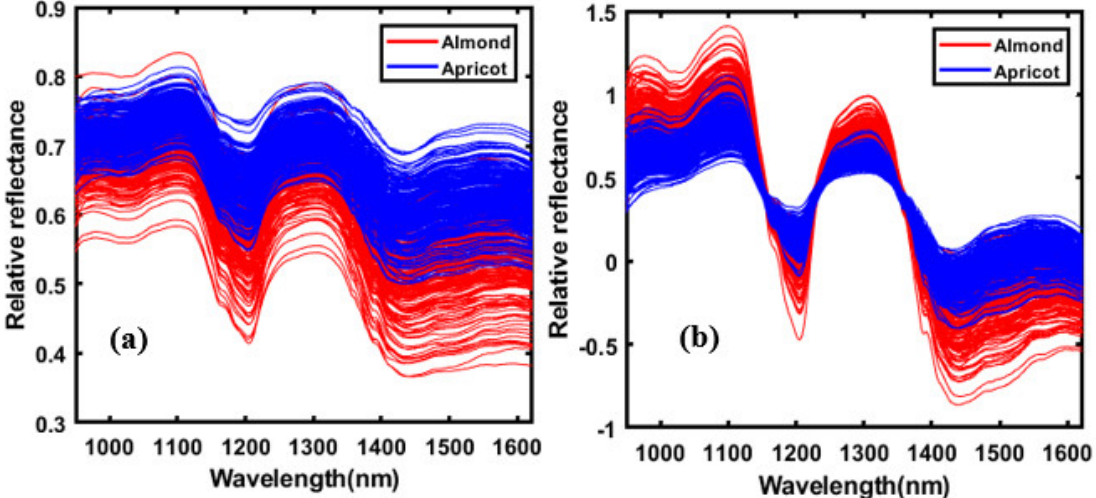
Figure 3. The raw and pre-processed spectral data of almond and apricot kernels. ( a ) The pure spectral data and ( b ) the standard normal variate (SNV) pre-processed spectra in the spectral region between 950 and 1622 nm.